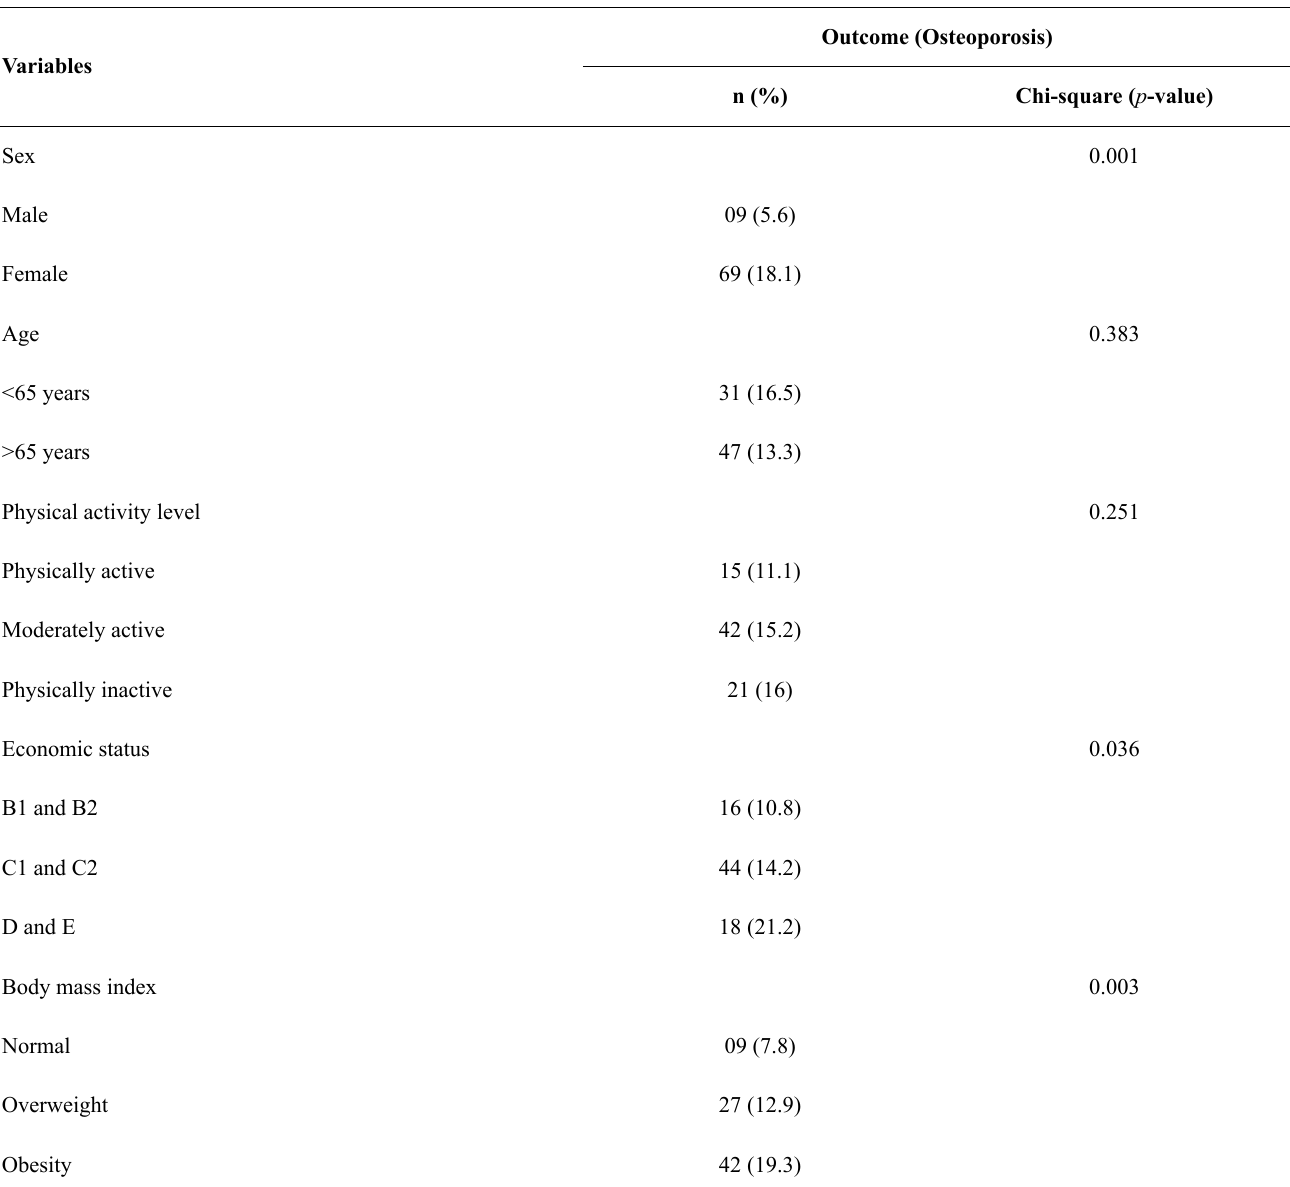
Table 1. Occurrence of osteoporosis according to descriptive characteristics of the sample (n= 78; Presidente Prudente,